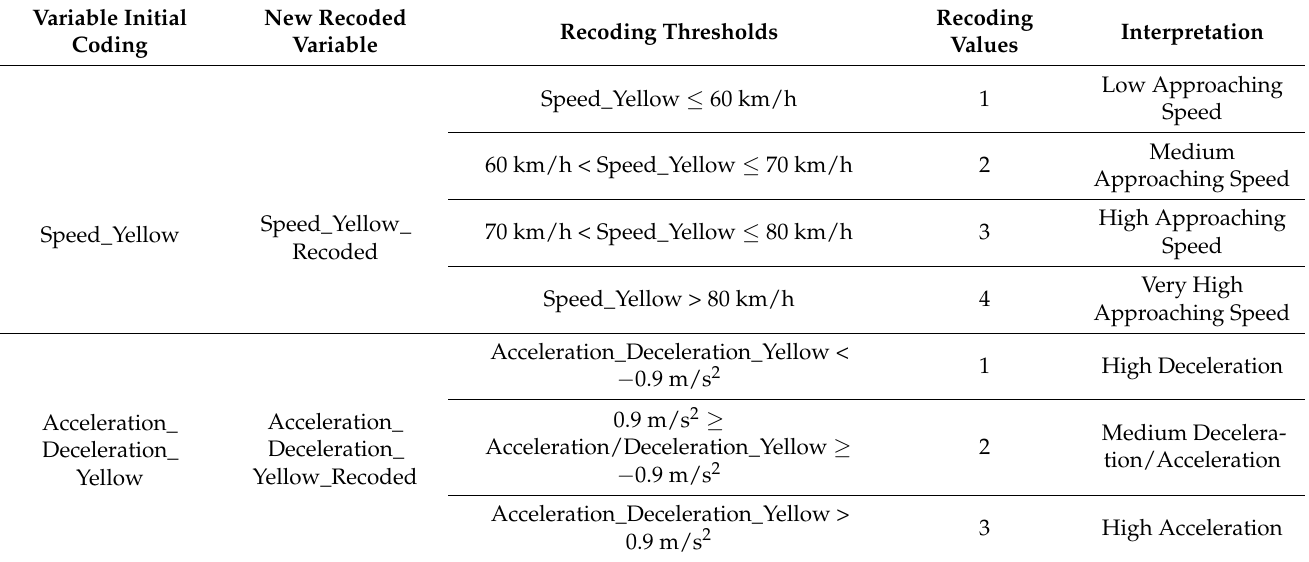
Table 1. Thresholds for approaching speed and acceleration/deceleration